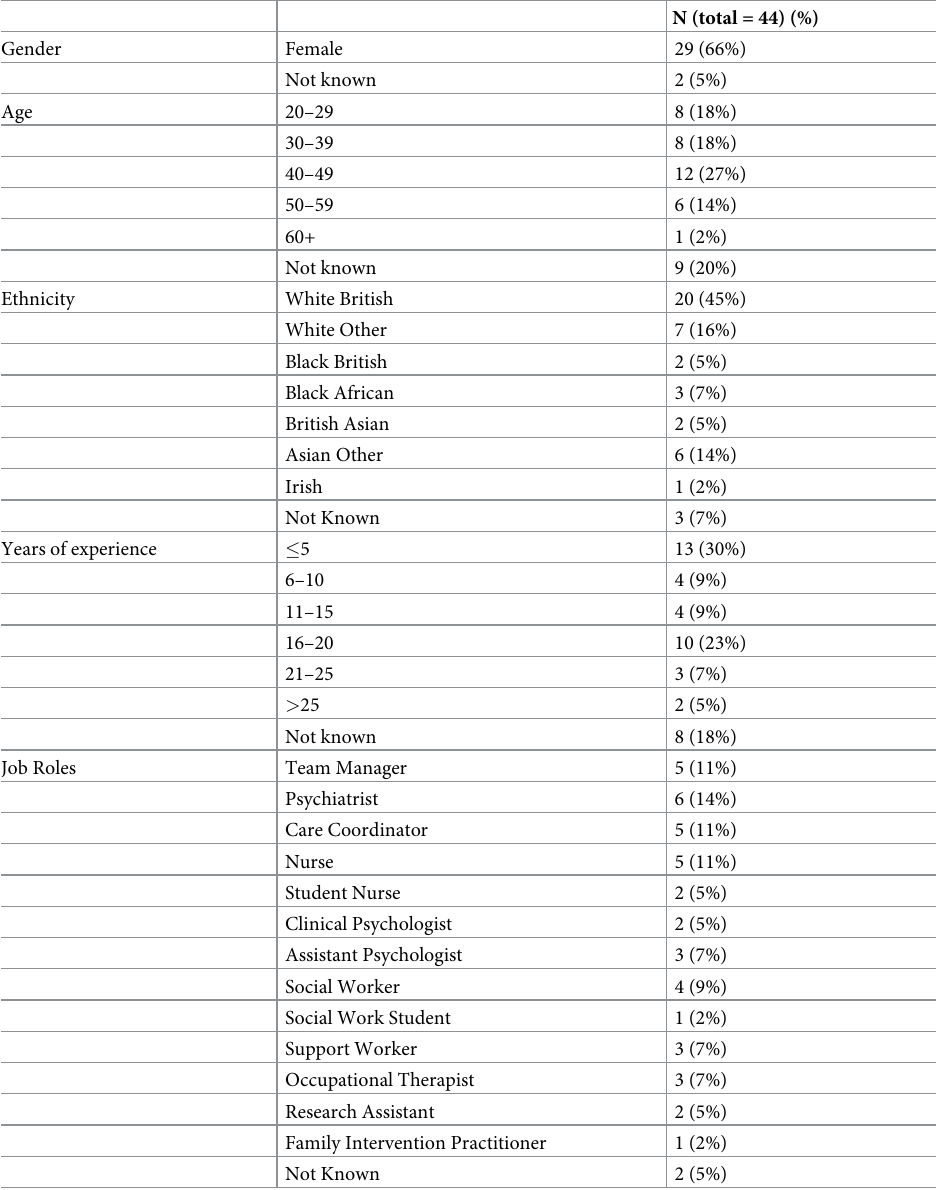
Table 2. EIS staff